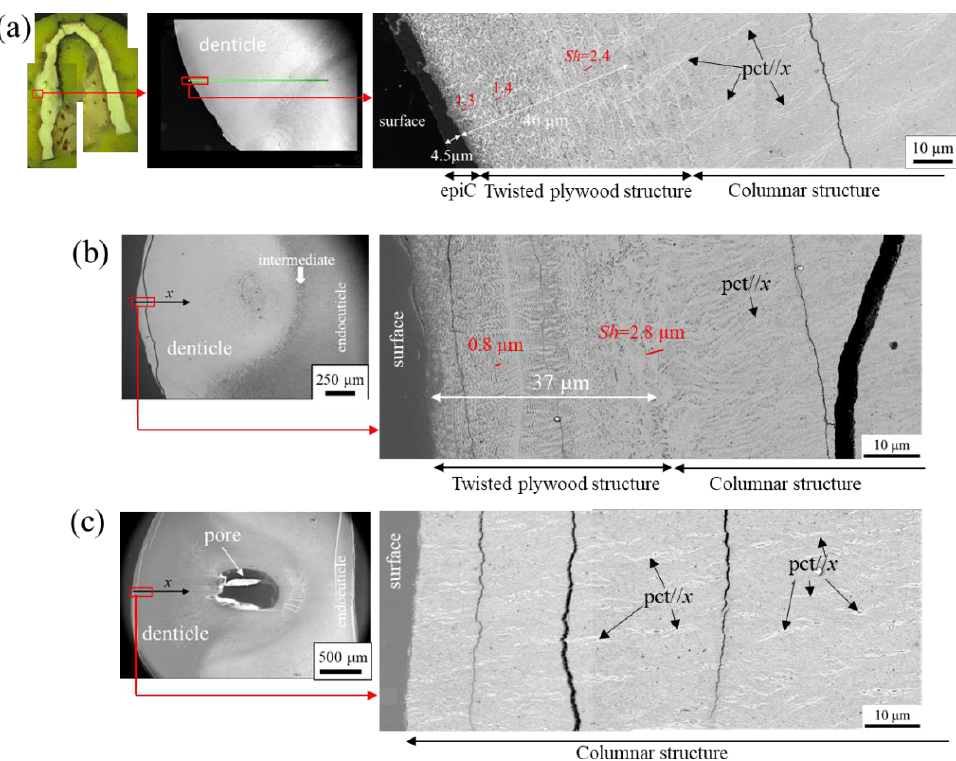
Figure 6. SEM micrographs of the denticle surface on the pinching side of the fixed finger of the left claw in coconut crabs of different sizes: ( a ) 1070 g, ( b ) 610 g, and ( c ) 300 g. Here, Sh denotes the stacking height of the twisted plywood structure, and pct denotes pore canal tubules.